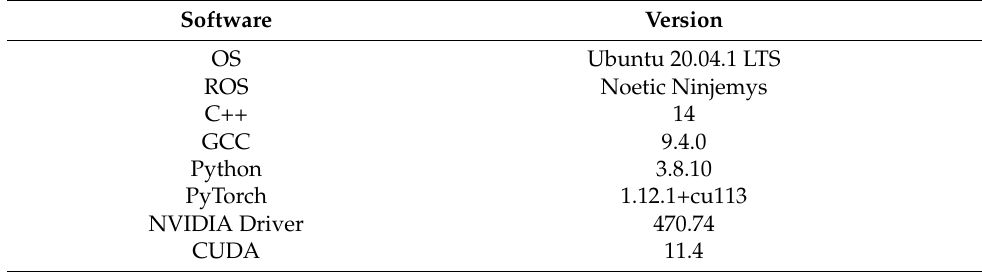
Table 2. Software environment.